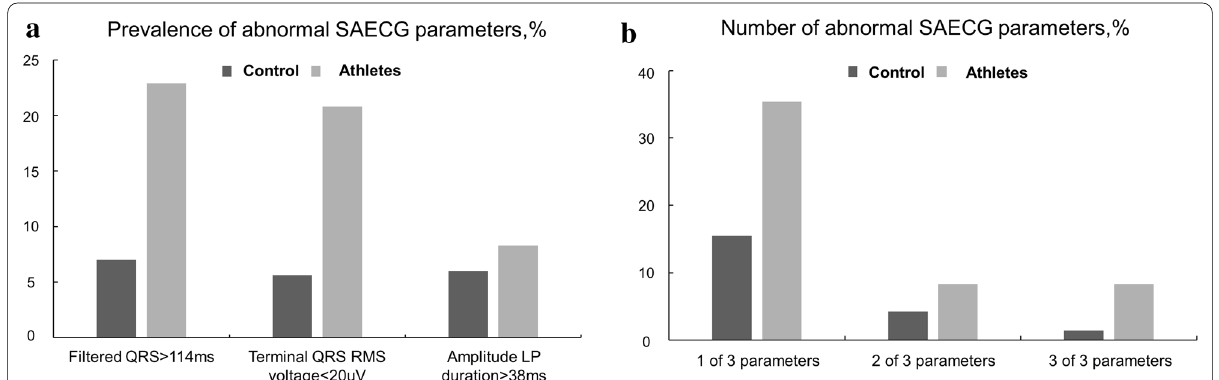
Fig. 3 Prevalence of abnormal signal‑averaged electrocardiographic parameter for ventricular late potentials (VLP) in study subjects. A) Prevalence of each VLP criterion. B) Comparison of number of positive VLP